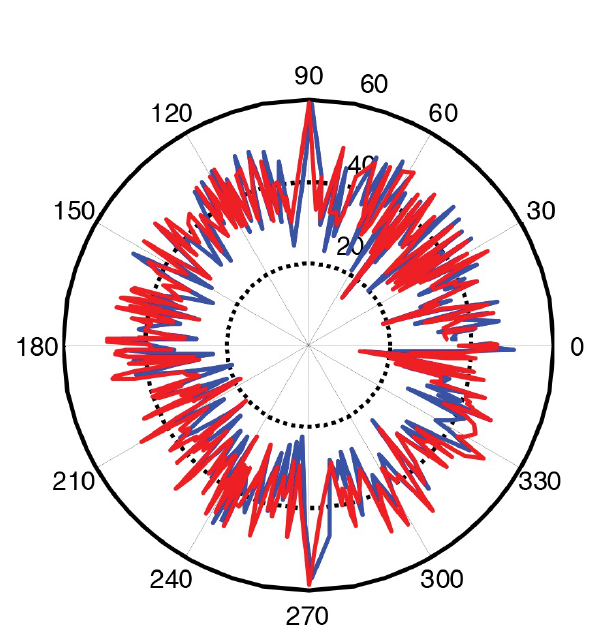
Fig. 10 Comparison of the measured RCS (blue) of Ship B and its true value (red). RCS, radar cross-section. 3. The echo intensity of Ship B is obtained by subtracting the noise amplitude from the echo amplitude.